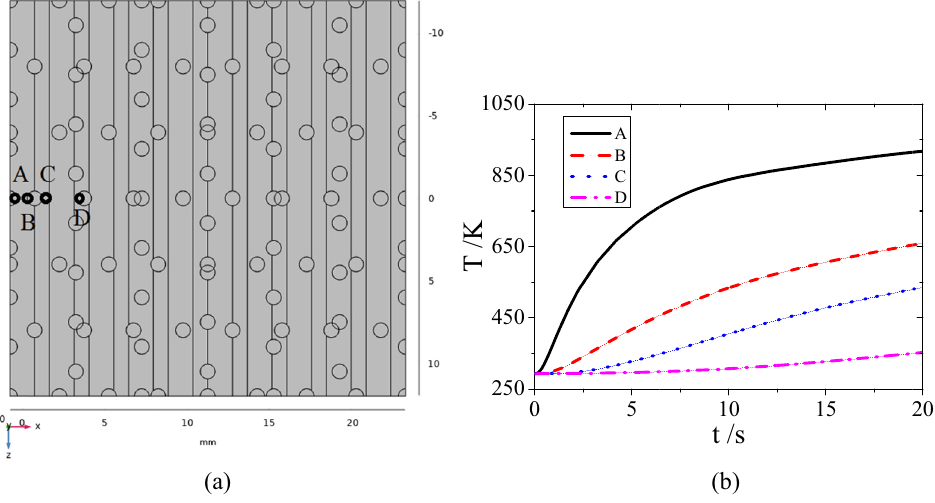
Figure 7: Temperature – time curves of monitoring points: ( a ) monitoring points and ( b ) temperature – time curves for points in ( a ) .